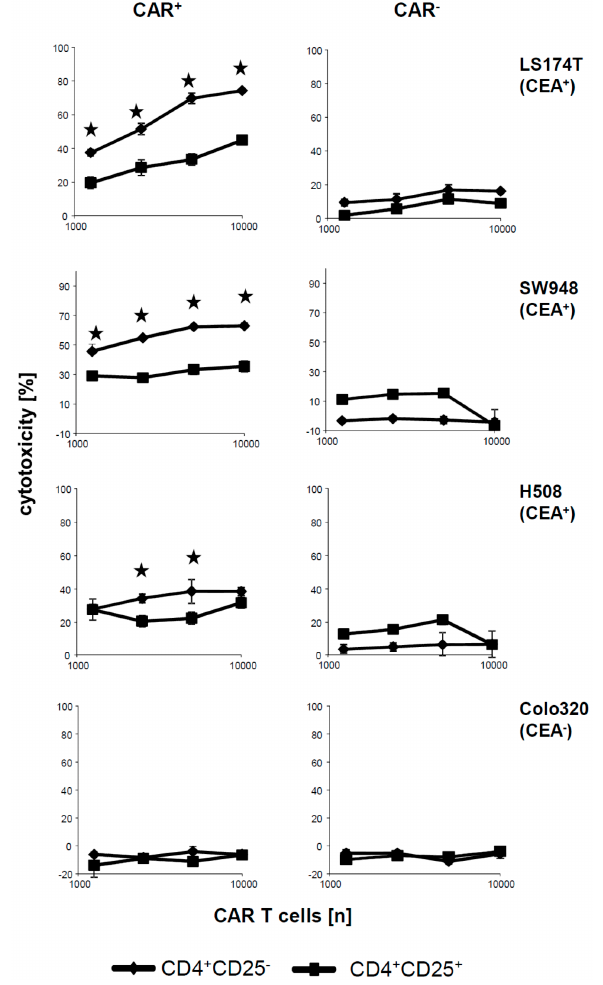
Figure 3. CD4 + CD25 − and CD4 + CD25 + CAR T cells represent CD4 + subpopulations with different lytic capabilities. CD4 + T cells were equipped with the anti-CEA CAR and CAR T cells (1.25–10 × 10 3 CAR Figure